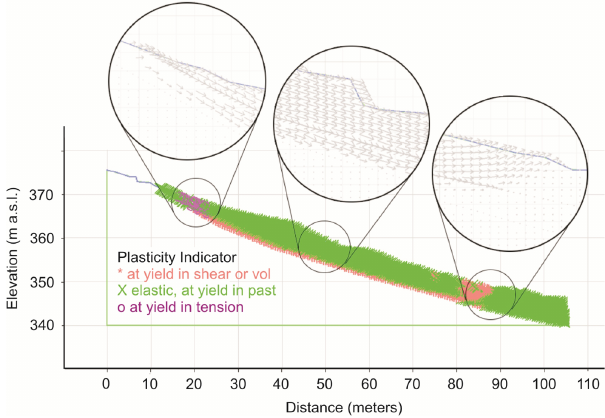
Figure 5. Success rate curves showing how the adopted model fits the instability conditions of the study